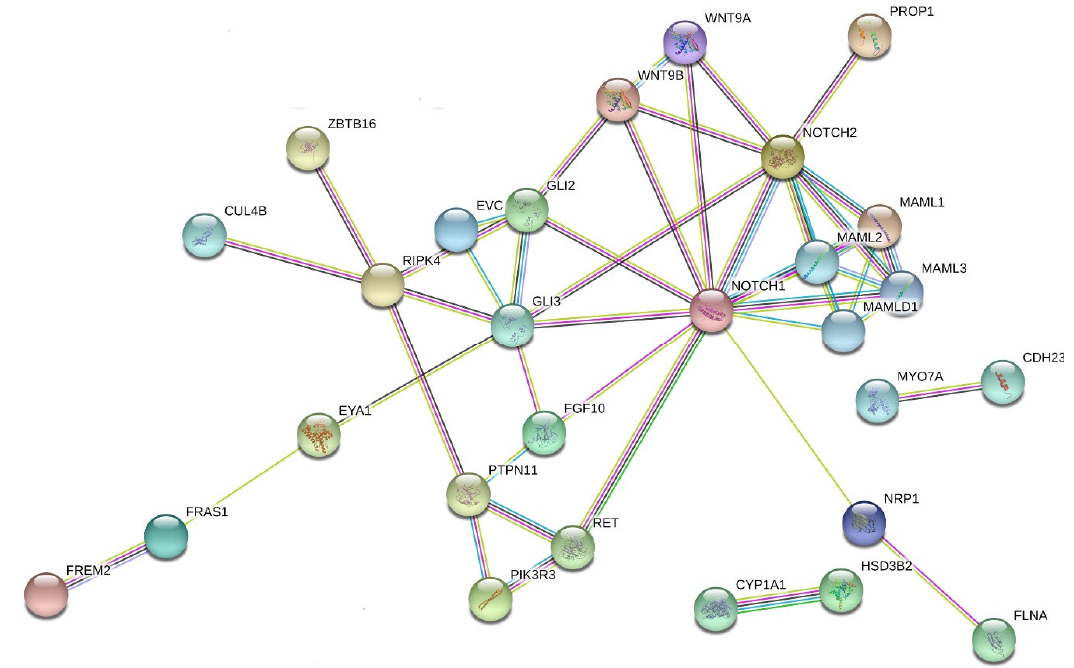
Figure 2. Interaction network of DSD- and MAMLD1 -related genes identified in DSD individuals harboring genetic variants in MAMLD1 . The scheme depicts an overview of detected genes and their interrelationship. For the search for functional human partners, we used the Search Tool for the Retrieval of Interacting Genes / Proteins (STRING, http: // string-db.org / ). Nodes represent proteins. Filled nodes show proteins with known or predicted 3D structure. Empty nodes depict proteins with unknown 3D structure. Candidate genes are underlined. Known interactions correspond to curated databases (turquoise lines) and experimentally determined interactions (pink lines). Predicted interactions correspond to gene neighborhood (green lines), gene fusions (red lines), and gene co-occurrence (blue lines). Other interactions correspond to text mining (yellow lines), co-expression (black lines), and protein homology (violet lines). Reproduced from